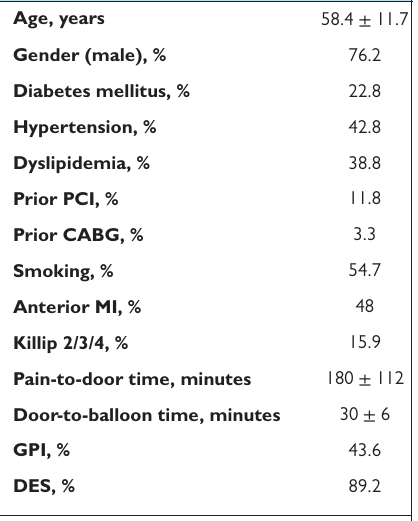
Table 1. Baseline Patient Characteristics